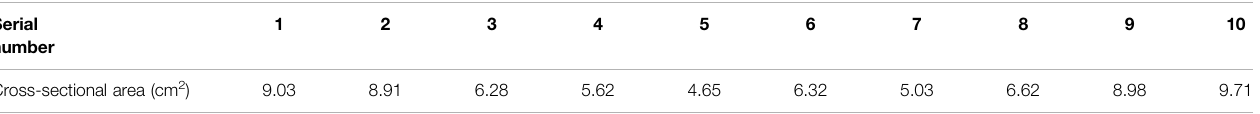
TABLE 1 | Optimized cross-sectional areas of beams.